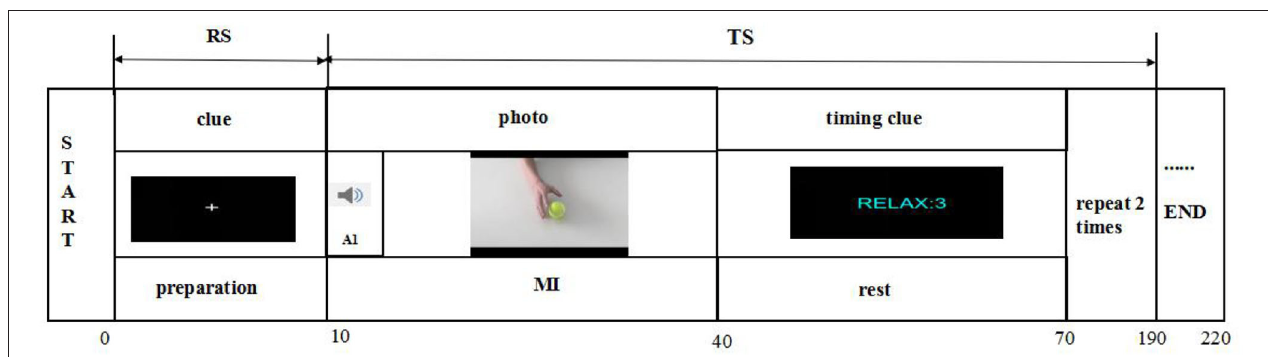
FIGURE 4 | Illustration of fNIRS testing. There are two states of fNIRS testing, namely, the rest state (RS) and the task state (TS). The RS is 10s, and the TS is a 180-s grasping task. The grasping task consists of three trials, and each trial is followed by a 30-s intertrial break.